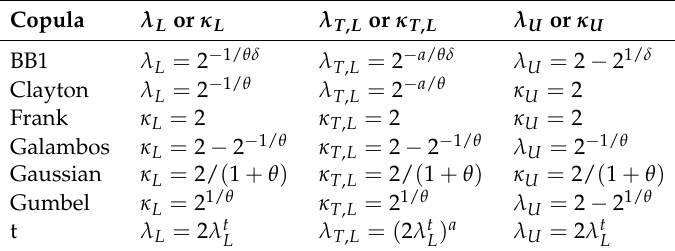
Table 1. Examples of tail orders and dependence